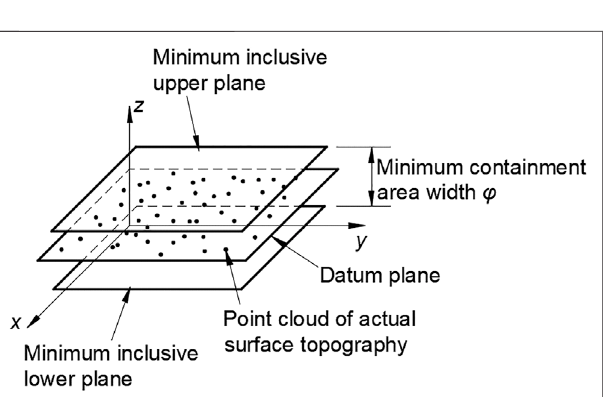
FIGURE 7 | Minimum zone of fl atness error.